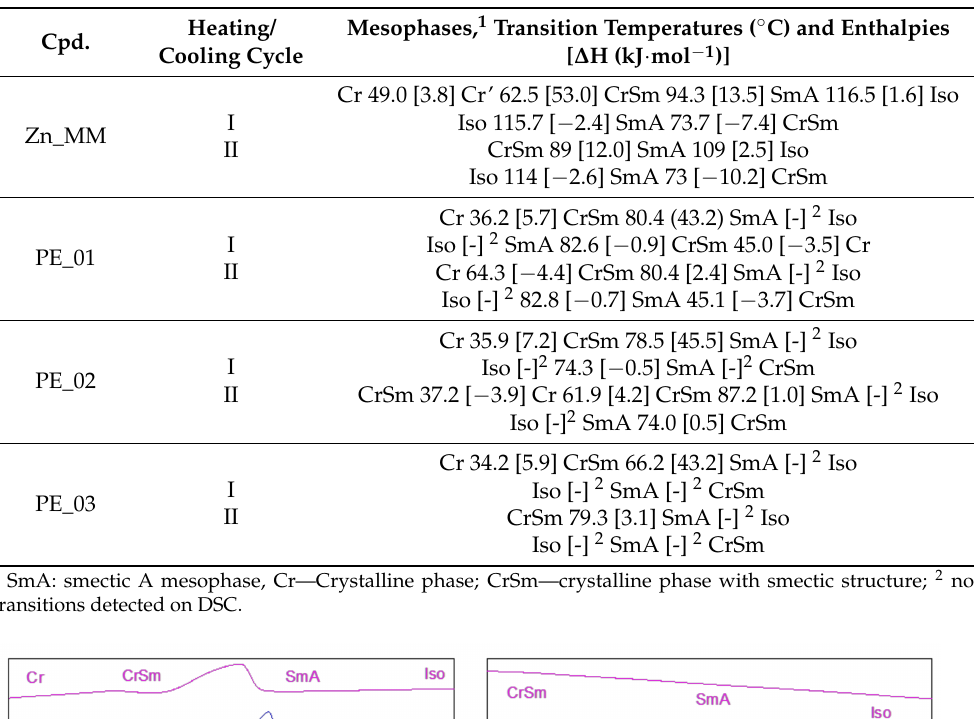
Table 2. Transitions temperatures and enthalpy for the pure Zn complex (Zn_MM) and the different mixtures.